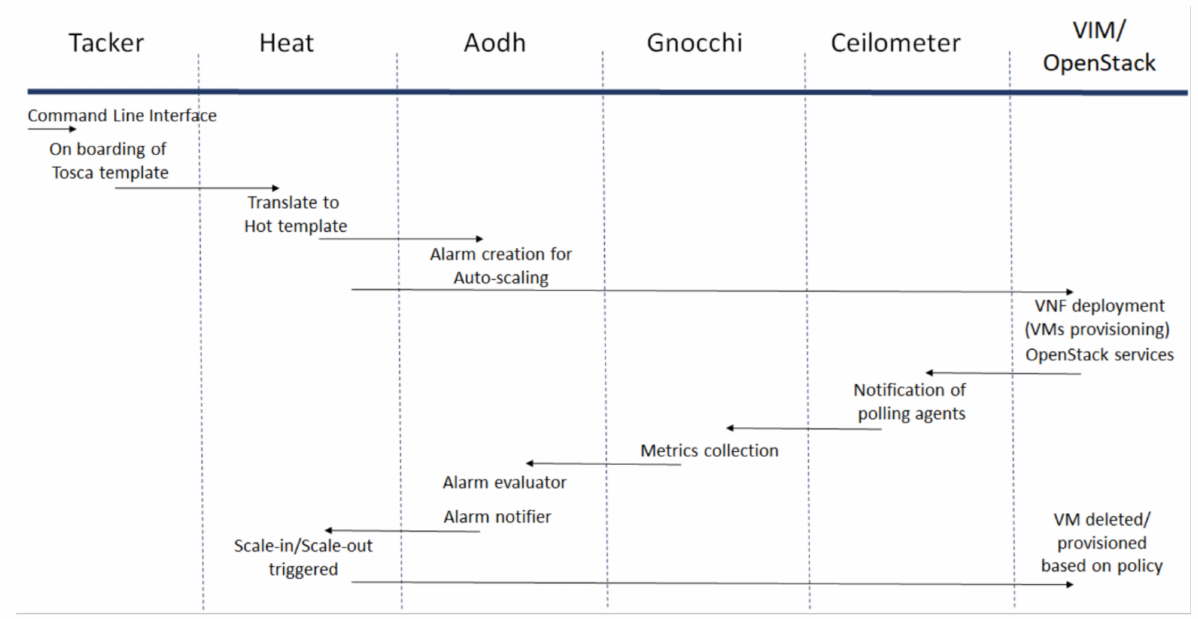
Figure 4. Flowchart of the proposed framework for auto-scaling of